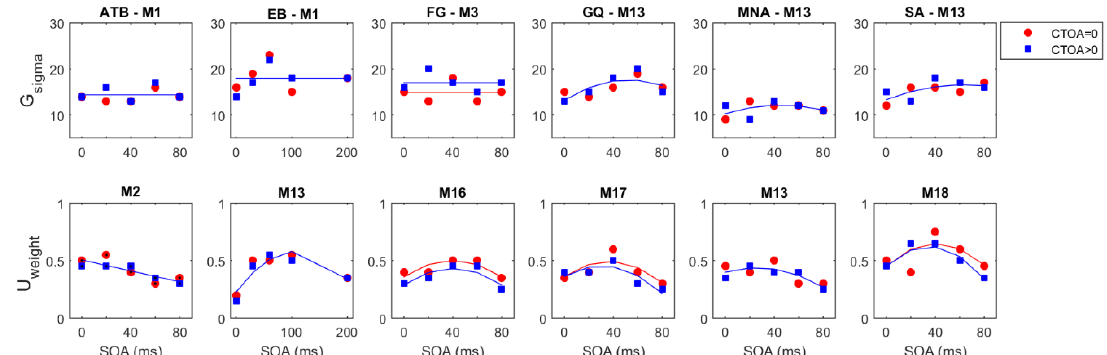
Figure A2. The transformed performance as a function of SOA for invalid trials in the exogenous attention condition for all CTOAs. The horizontal axes represent SOA and the vertical axes represent transformed performance. Red color represents zero CTOA and blue color represents positive CTOA value (ranging from 80 to 120). The dotted horizontal lines indicate baseline performance. The markers and the dashed lines represent empirical data whereas the solid lines show the best-fit regression model. Each panel shows data from a single observer. The best regression model (see Table 2) is given on top of each panel. Error bars represent ± SEM across trials (n = 100).